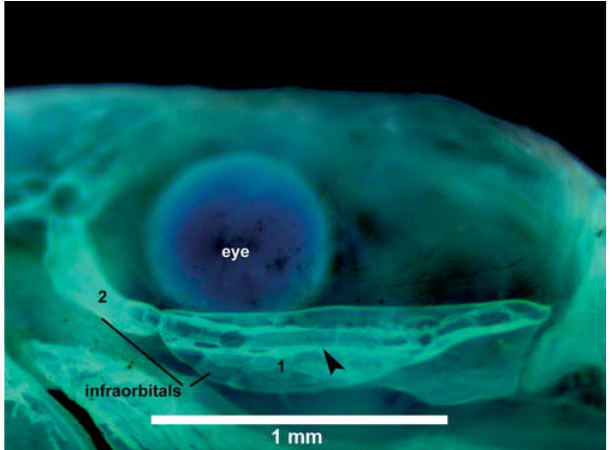
Fig. 3. Orbital region of Aspidoras psammatides , paratype, MNRJ 21709, 22.6 mm SL, right side. Arrow: latero-sensory